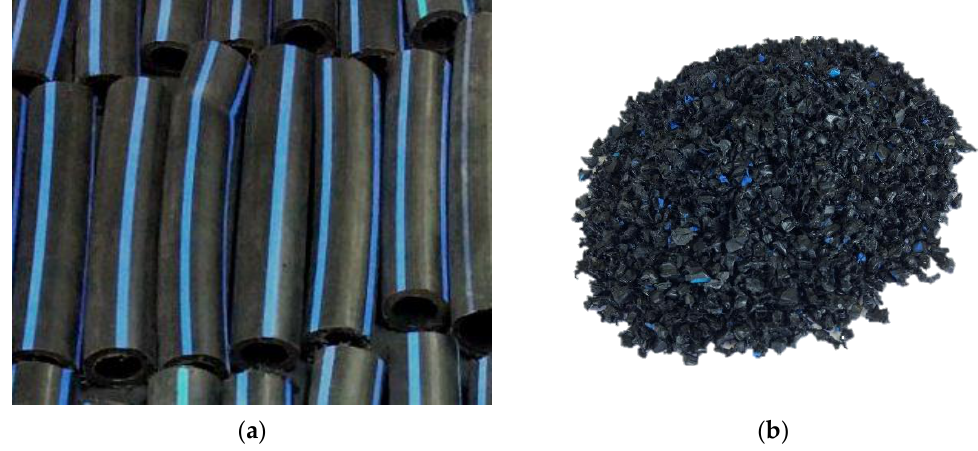
Figure 1. ( a ) Polyethylene pipes to be recycled. ( b ) Polyethylene pellets obtained from the crushing of the original material.